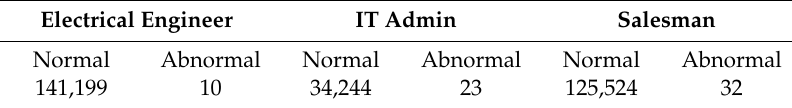
Table 4. Frequency of records of three